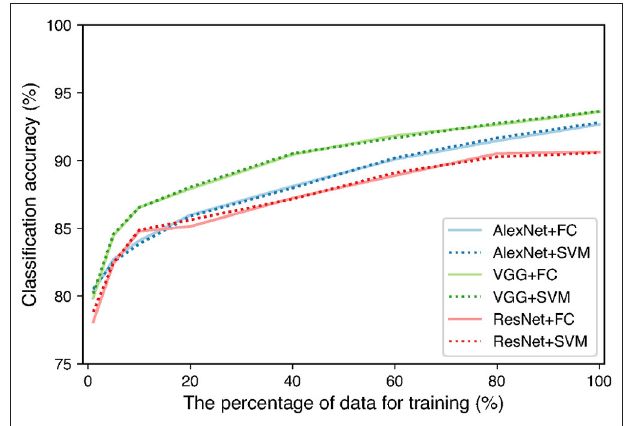
FIGURE 7 | Confusion matrix when using VGG-19 as the convolutional neural network and the fully connected layer as the classifier.